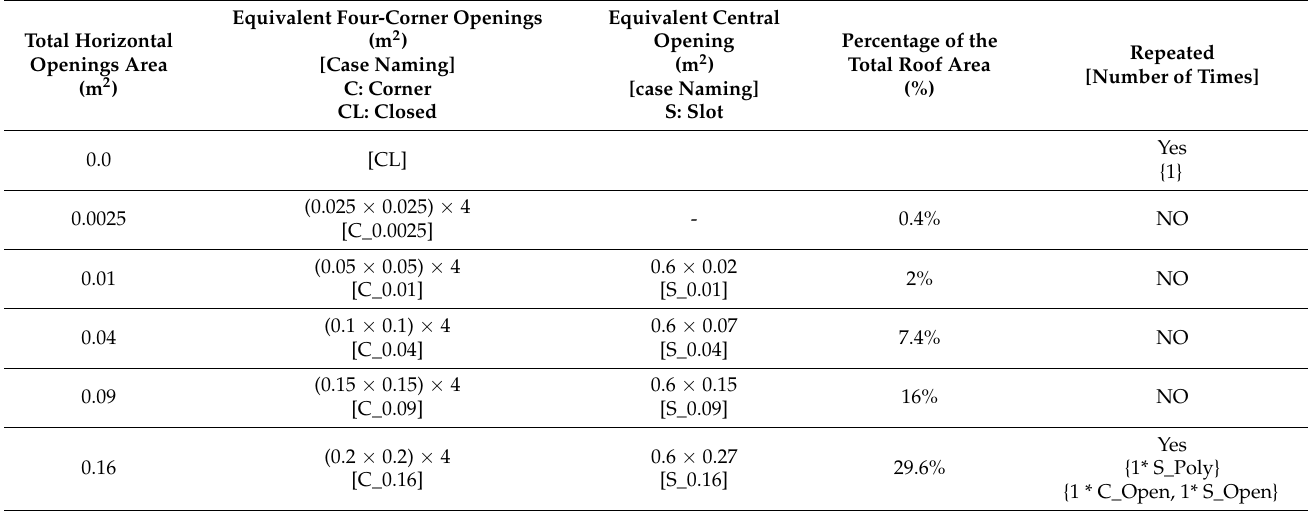
Table 1. Experimental